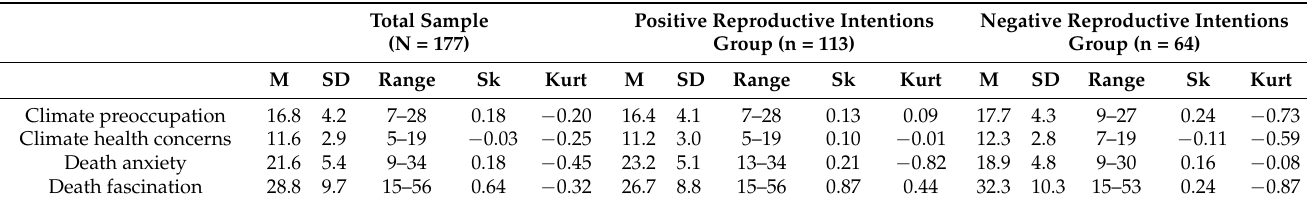
Table 2. Descriptive statistics for climate change perception, death anxiety, and death fascination in the total sample and subsamples according to reproductive